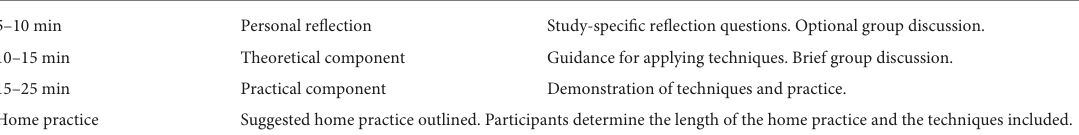
TABLE 2 Mindful practice for teachers program summary 45-min session.